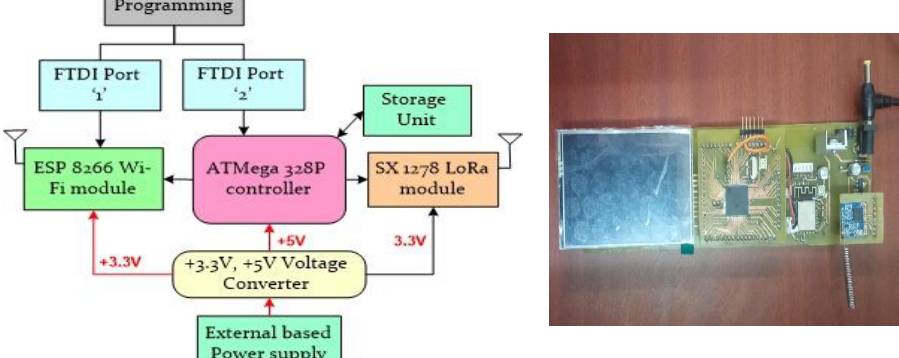
Table 4. Technical specifications of ESP 8266